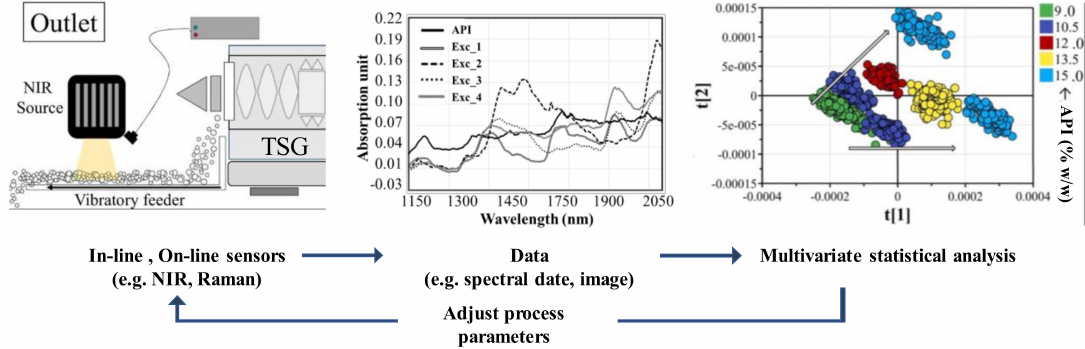
Figure 1. Summary of the approach to control the pharmaceutical manufacturing process using the process analytical technology tool [34]. The figure was modified, with permission from